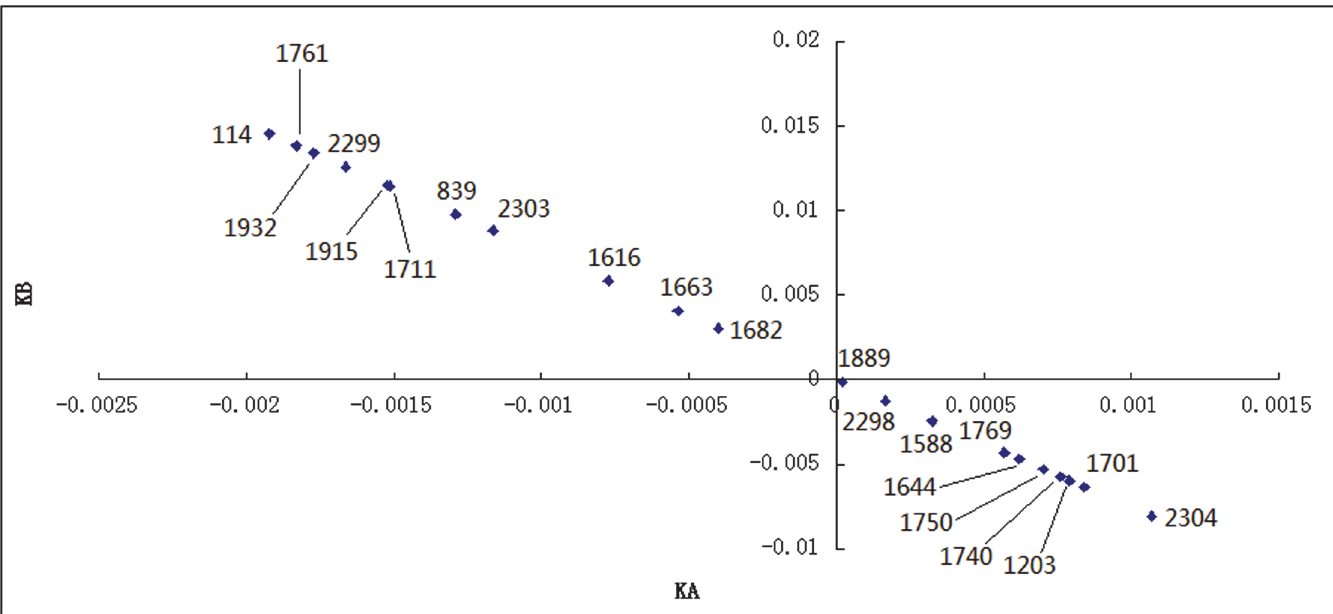
Fig 2. The scatter diagram of the sites. The scatter diagram of the sites was drawn with K A ( x j ) as axis X and K B ( x j ) as axis Y , and Site 114, 1761, 1932, 1889 and 2304 were selected as the monitoring sites.